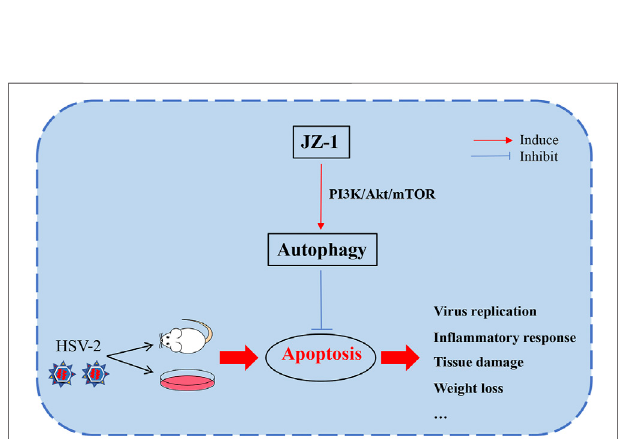
FIGURE 9 | JZ-1 alleviates HSV-2 infection-induced genital herpes in balb/c mice by inhibiting cell apoptosis via inducing autophagy. In the pathogenesis of GH, HSV-2 infection leads to massive cell apoptosis, which largely promote the progression of disease. JZ-1 administration can alleviate HSV-2 infection-induced GH in balb/c mice by inhibiting cell apoptosis via inducing autophagy, and the underlying mechanisms may be associated with the inhibition of PI3K/Akt/mTOR